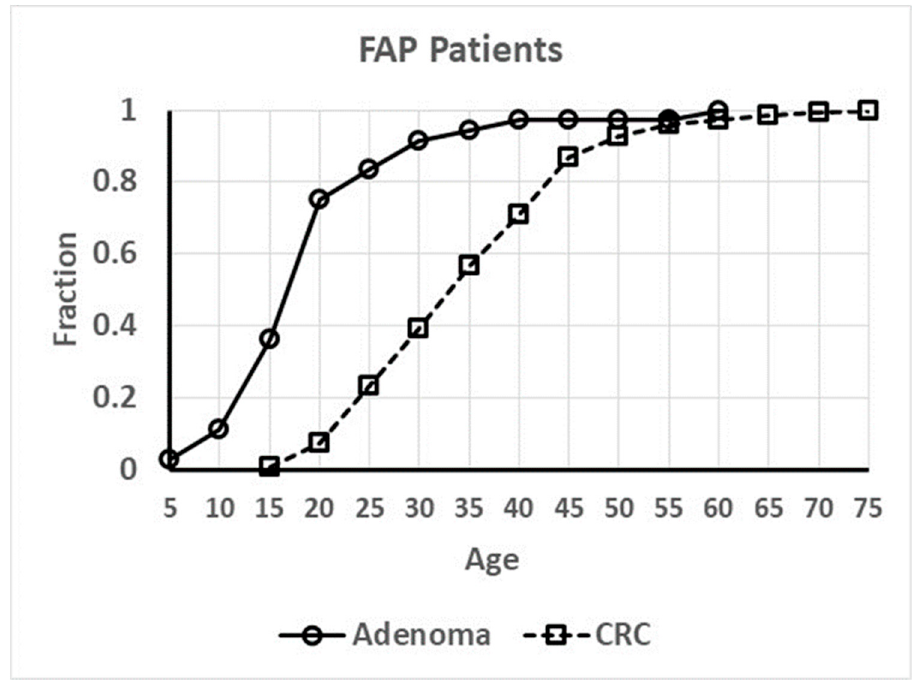
Figure 1. Age at colonic tumor development in familial adenomatous coli (FAP) patients.